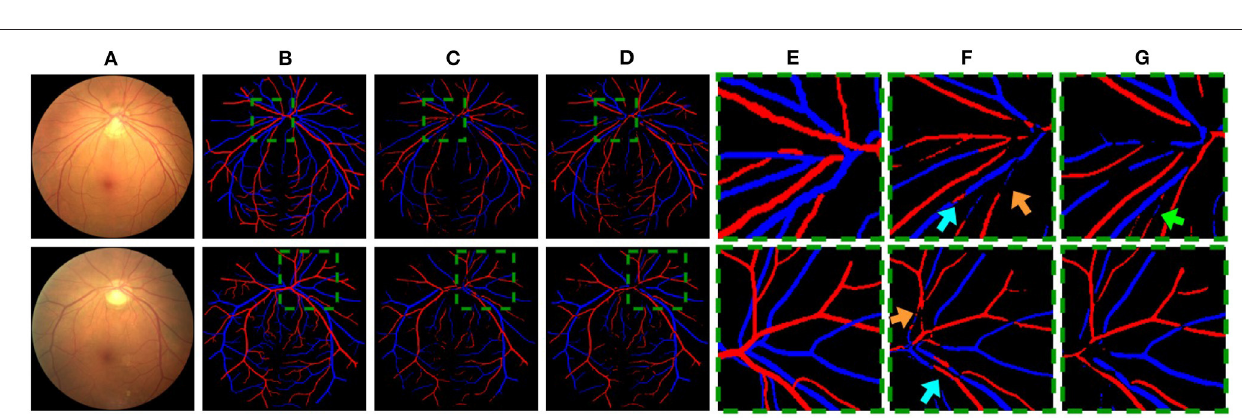
FIGURE 7 | (A) Example images. (B,E) The corresponding ground truth and zoomed in regions. (C,F) CNN outputs. (D,G) GCN outputs. In (F) , cyan arrows highlight some vessels with multiple class assignments, and orange arrows mark limited vessel connectivity in the CNN-only outputs. In (G) , a green arrow highlights a failure case where multiple class assignments are present in the GCN output.